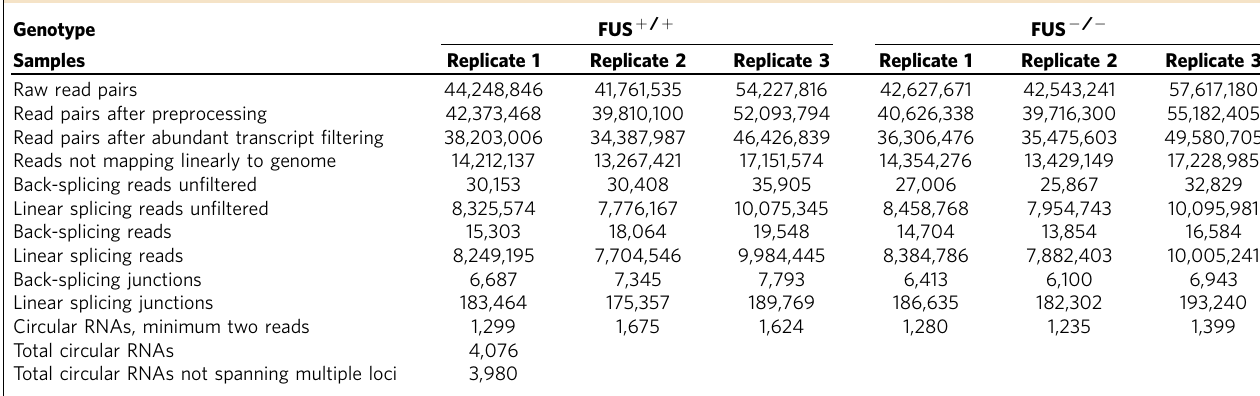
Table 1 | Summary of RNA-seq results for six different samples. Genotype